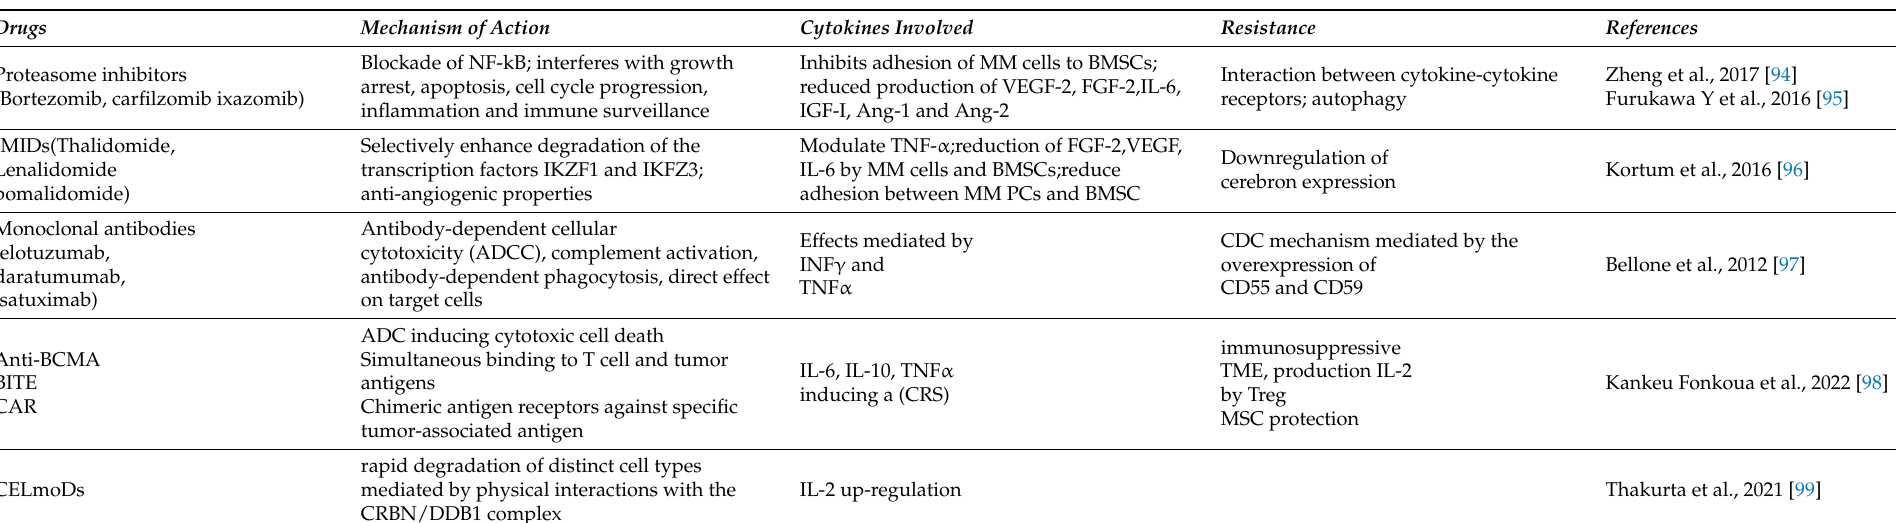
Table 1. Drugs, mechanisms of action, involved cytokines and related clinical